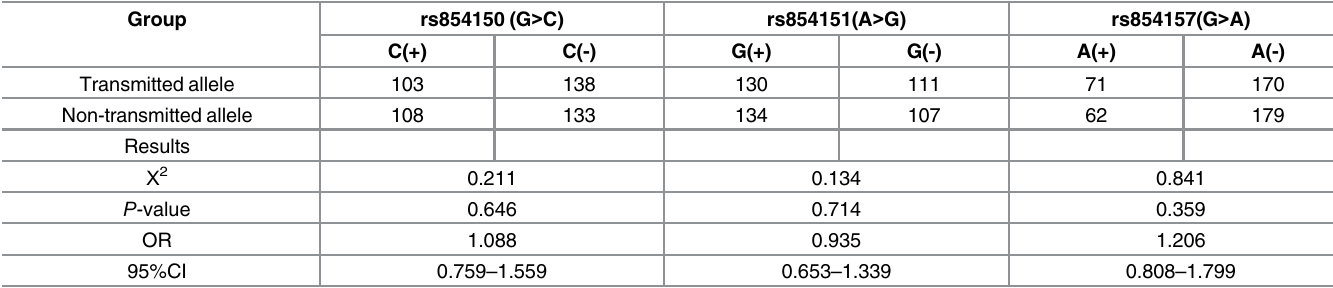
Table 2. HRR results of three genetic loci in 241 trios.